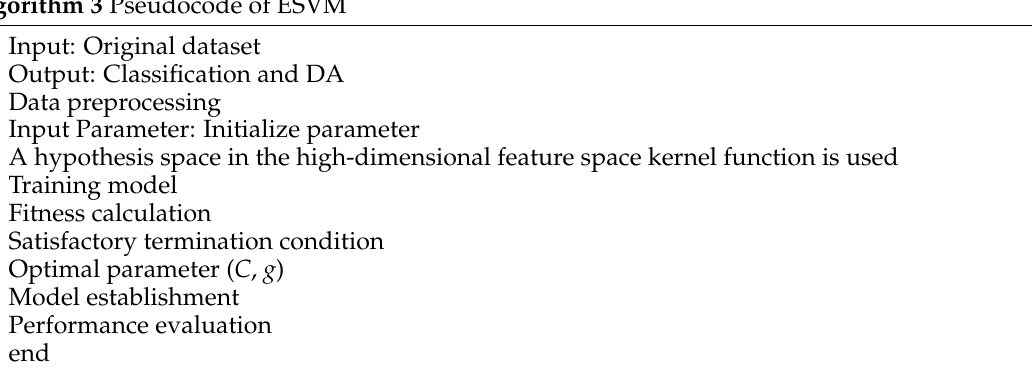
Algorithm 3 Pseudocode of